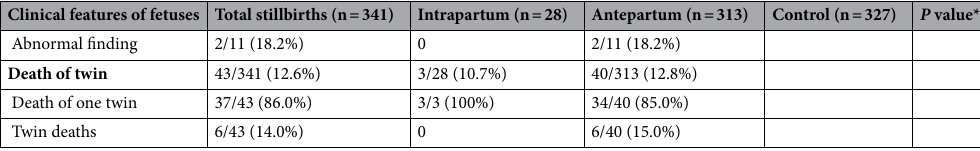
Table 3. Baseline demographic and clinical features of the stillbirths. Data are n/N (%). *Comparison of fetuses of antepartum stillbirths (313 stillbirths from 310 mothers) and control fetuses (the number of control